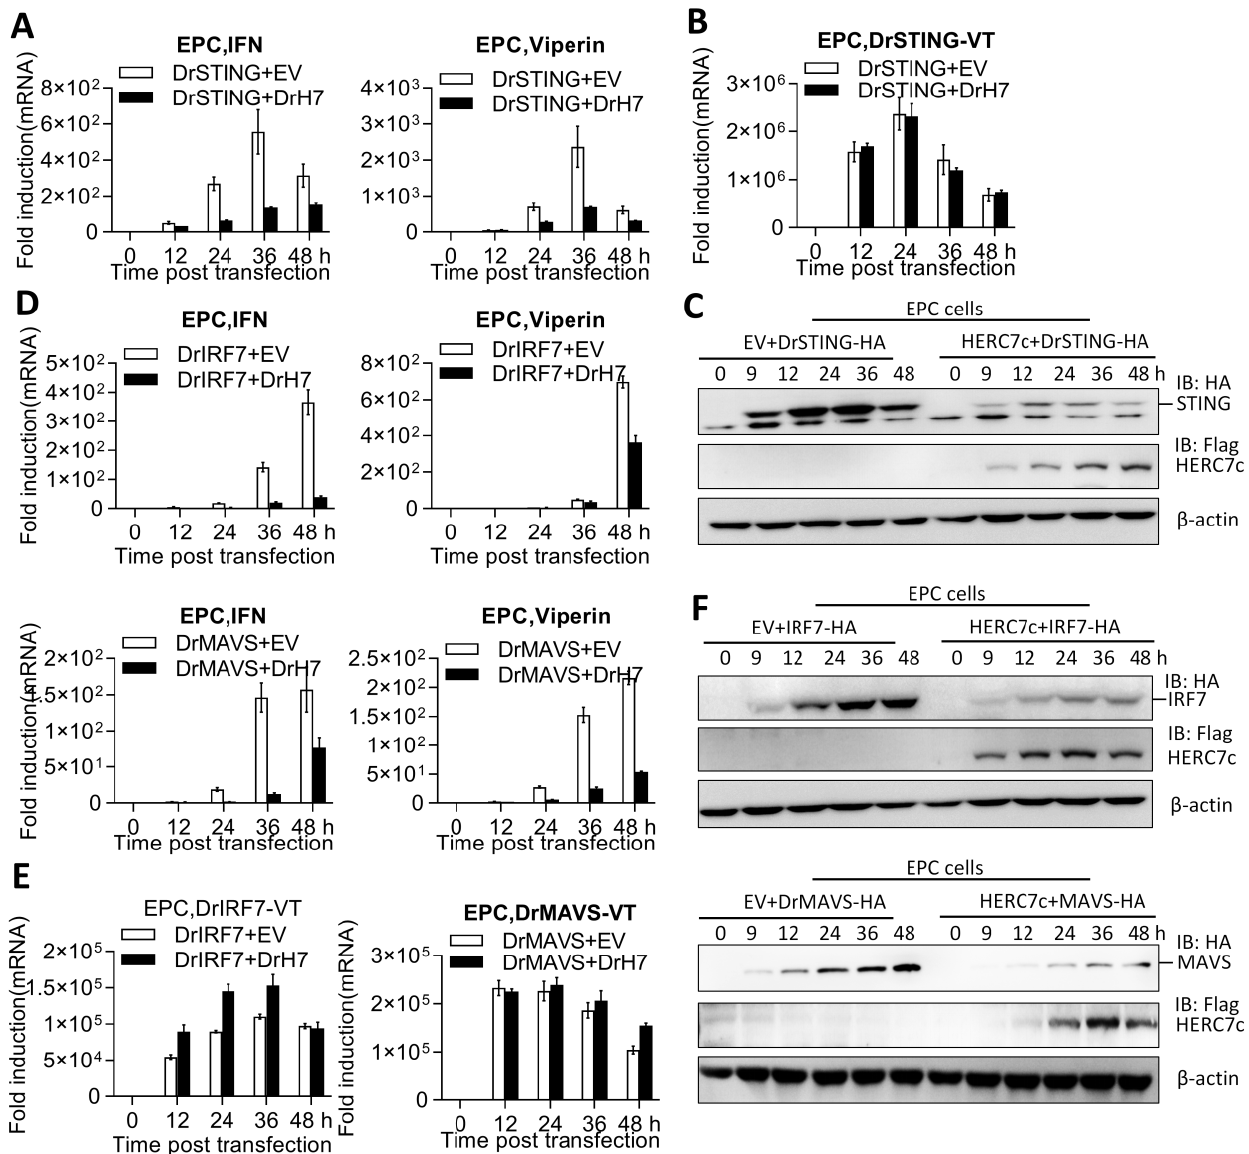
Figure 6. Zebrafish HERC7c attenuates STING, MAVS, and IRF7 protein levels to downregulate the IFN response . ( A , B ) Zebrafish HERC7c attenuated STING-directed ifn gene transcription but not sting gene transcription. EPC cells seeded in 3.5 cm 2 dishes were cotransfected with zebrafish STING-HA and zebrafish HERC7c-Flag (1 µ g each) for different time points, followed by RT-PCR analysis of cellular ifn and viperin ( A ) and the transfected herc7c and sting ( B ). Error bars represent SD obtained by measuring each sample in triplicate. ( C ) Zebrafish HERC7c attenuated zebrafish STING protein level. EPC cells seeded in 3.5 cm 2 dishes were cotransfected with zebrafish HERC7c-Flag and zebrafish STING-HA (1 µ g each) for different time points, followed by Western blotting analyses of STING protein. ( D – F ) Zebrafish HERC7c attenuated IRF7- or MAVS-directed ifn gene transcription. EPC cells were cotransfected as in ( A , B ) by replacing zebrafish STING with zebrafish IRF7 or MAVS, followed by RT-PCR analyses ( D , E ) or Western blotting ( F